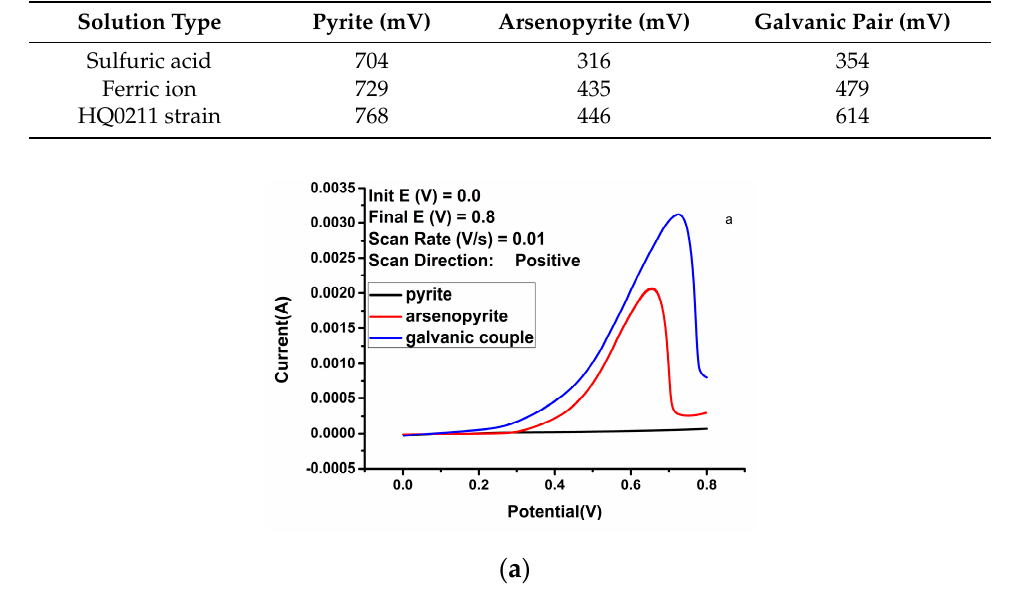
Table 1. The mean open circuit potentials (OCPs) of pyrite, arsenopyrite, and the galvanic pair in the investigated solutions.